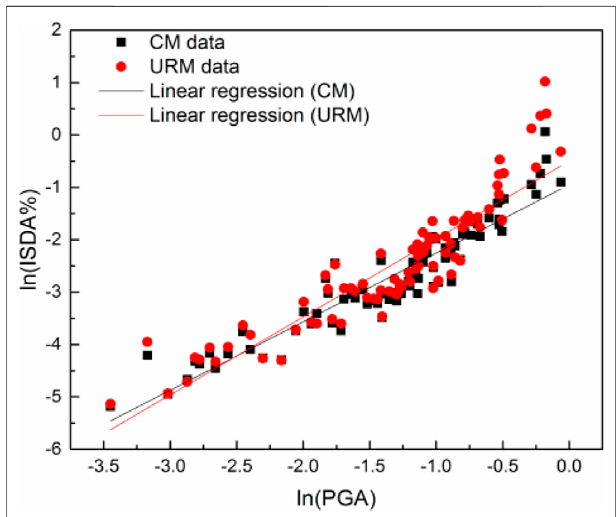
FIGURE 7 | Probabilistic seismic demand model of URM and CM subjected to mainshock